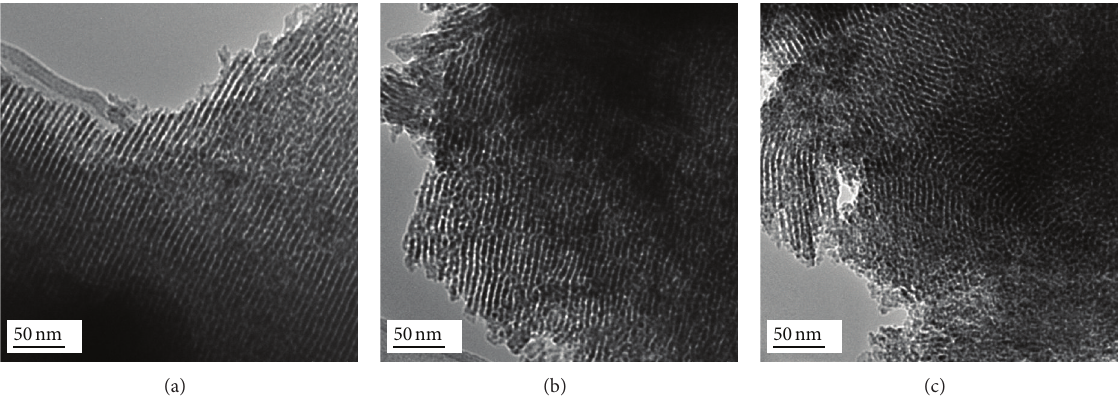
Figure 4: TEM images of the 0Fe-MBG/C (a), 5Fe-MBG/C (b), and 10Fe-MBG/C (c) composite scaffolds. Table 2: Structural parameters and drug loading of the Fe-MBG/C and other MBG composite scaffolds.